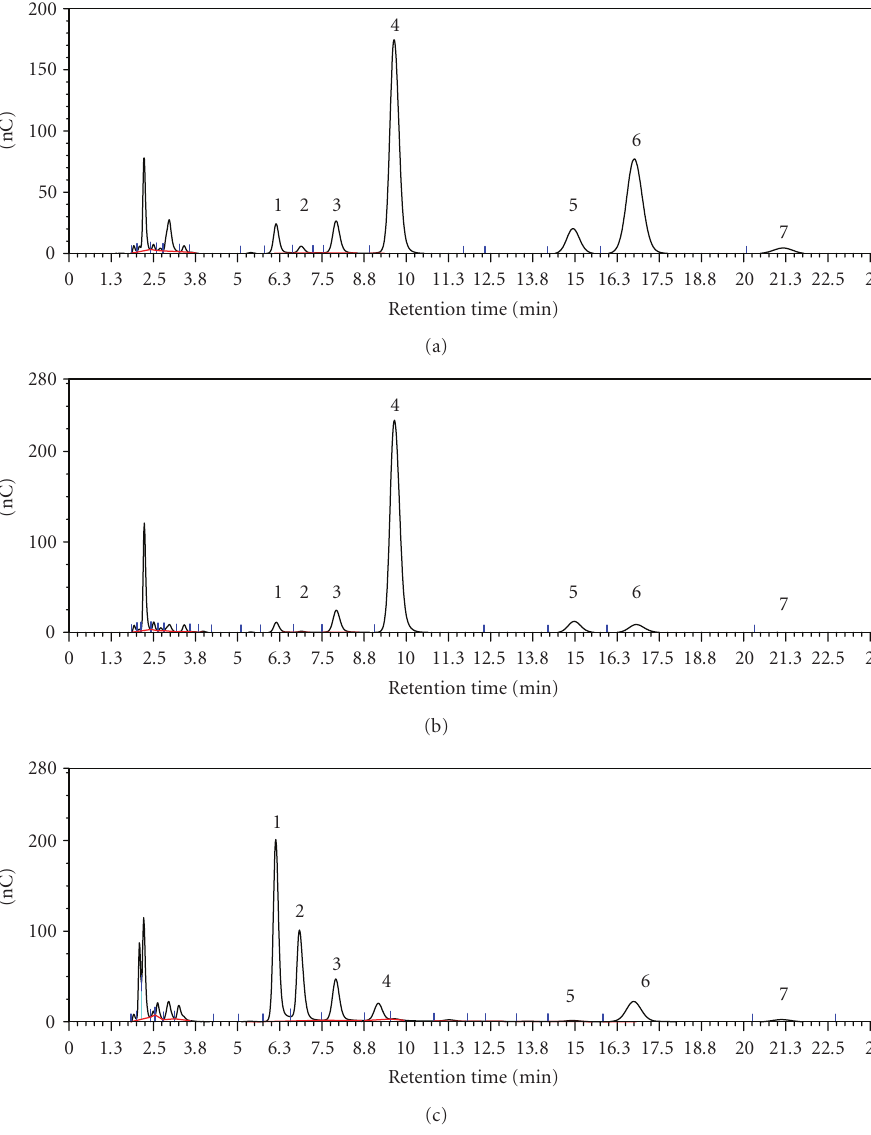
Figure 1: HPAEC-PAD chromotograms of soybean seed sugars in Ozark (a), 03CB-14 (b), and PI 417559 (c): glucose (1), fructose (2), melibiose (3), sucrose (4), ra ffi nose (5), stachyose (6), and verbascose (7). Unidentified peaks are not